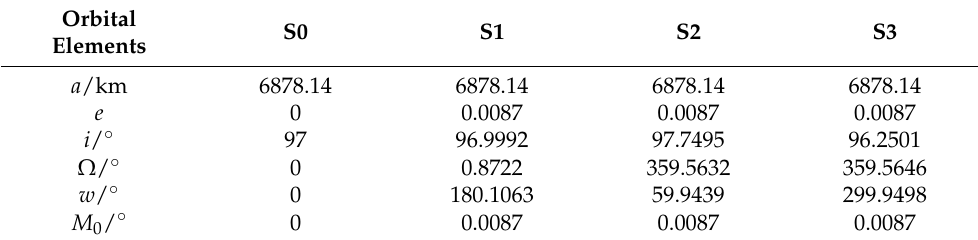
Table 2. Orbital elements.